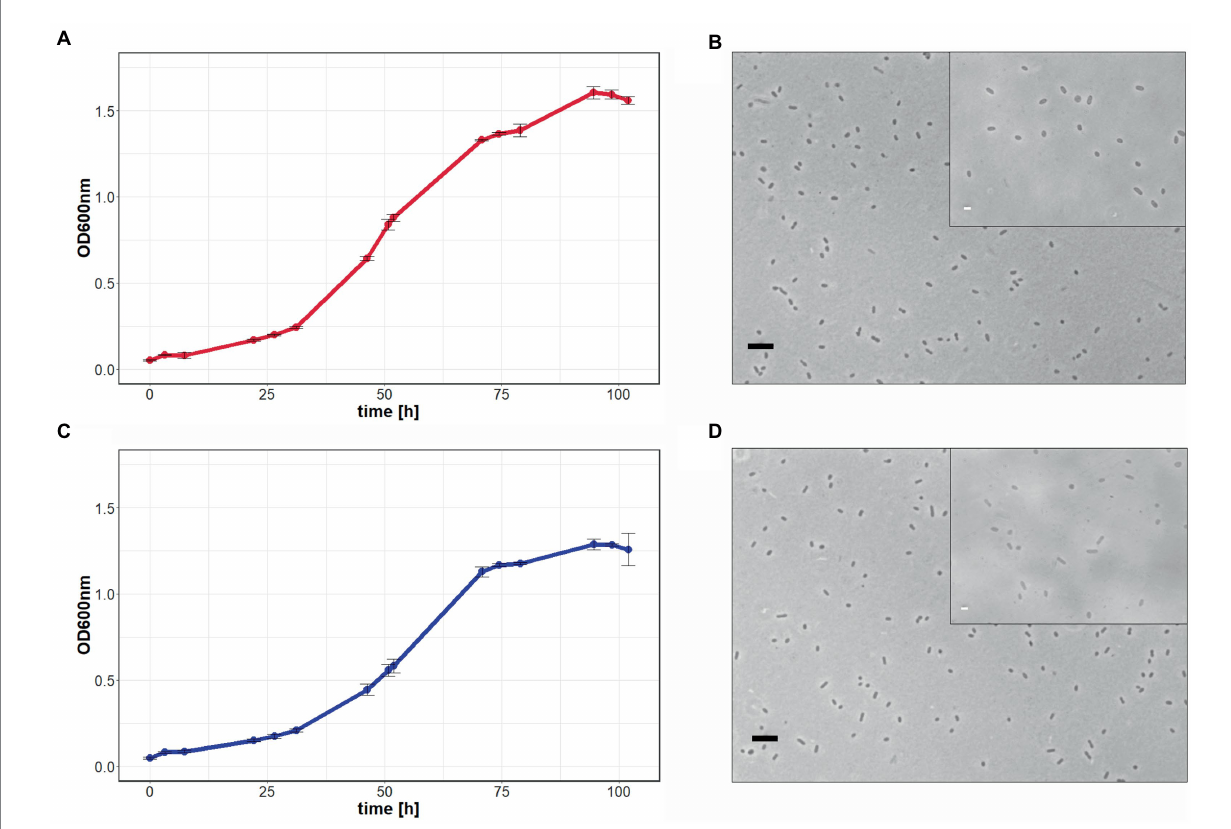
FIGURE 2 Growth comparison of Hrr. lacusprofundi ACAM34_UNSW and ACAM34_UNSW Δ pyrE2. The growth of wild-type (A) and mutant cells (C) in rich medium was observed by optical density measurements at 600 nm (OD 600 nm ) over 102 h. Points represent the average values and each time point measured, including the standard deviation represented by error bars ( n = 3). Light microscopy images of wild-type (B) and mutant cells (D) represent one of the three biological replicates (Supplementary Figure 4). Larger image at 400× magnification, black scale bar indicates 10 μ m, inlet at 1,000× magnification, white scale bar indicates 2 μ